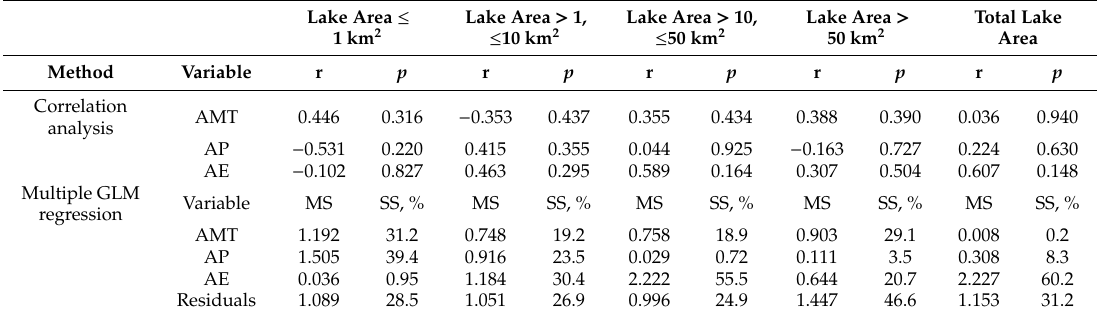
Table 1. Correlation and generalized linear model (GLM) analysis between di ff erent grades of lakes and climate factors (temperature, precipitation, evaporation) from 1985 to